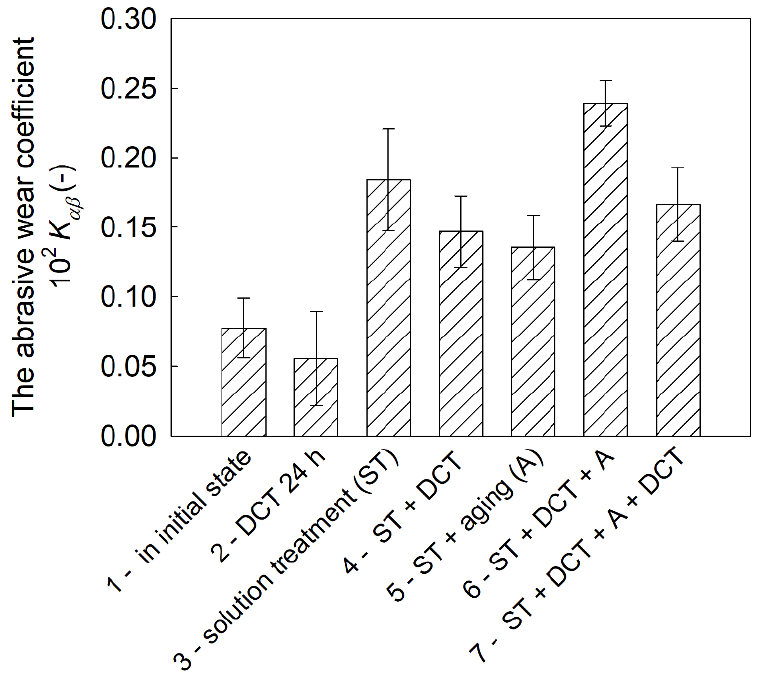
Figure 10. Changes in the abrasive wear resistance coefficient of a magnesium alloy containing rare earth metals in the initial state and after different heat treatment variants combined with